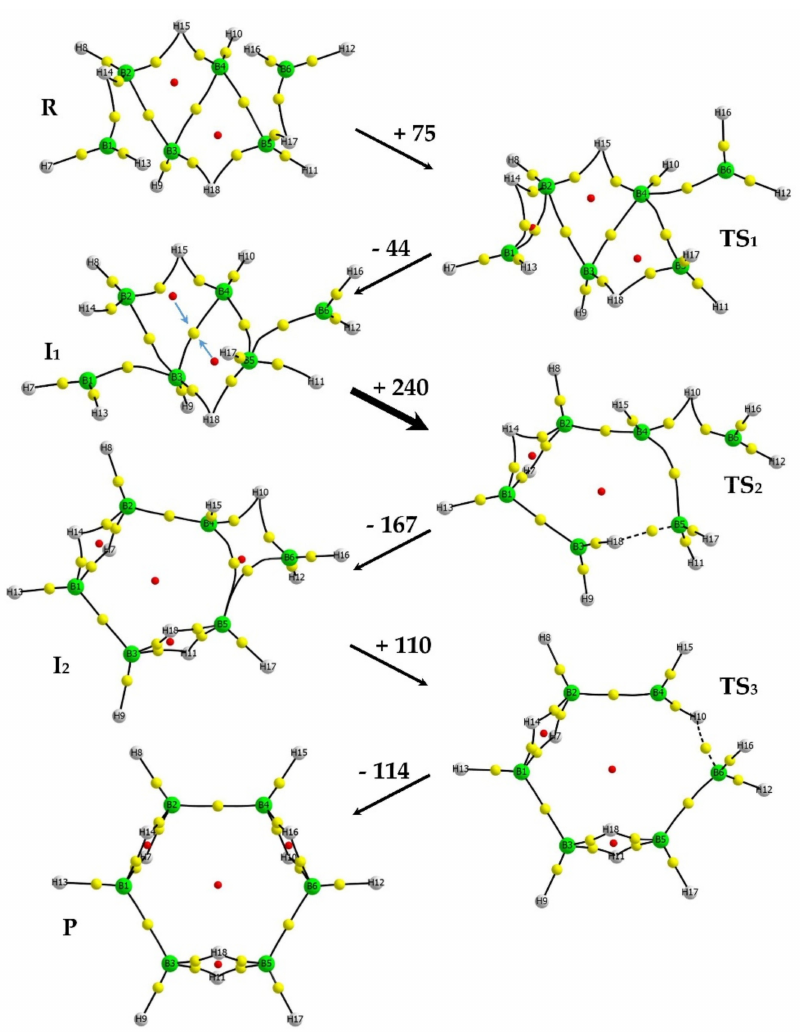
Figure 5. QTAIM critical points and bond paths (solid black line) of the stationary points (SP) along the IRC from Figure 2 for the 3D → 2D isomerization of hexaborane(12), with energy barriers separating the SP. Red and yellow circles correspond to ring critical points (RCP) and bond critical points (BCP), respectively. The two arrows in I 1 indicate the collapsing of the two RCP into one RCP in TS2. M06-2X/aug-cc-pVDZ